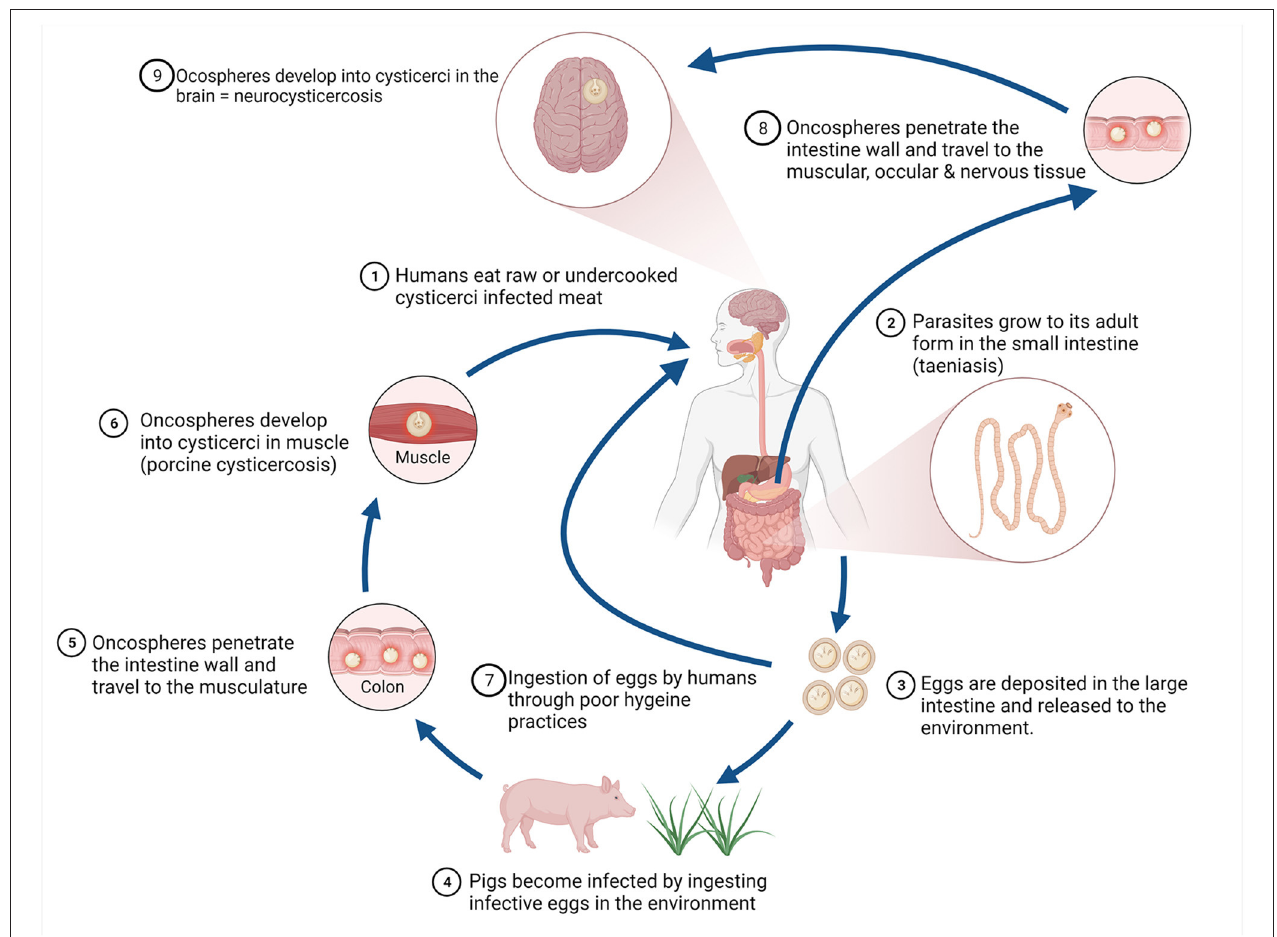
FIGURE 1 | Life cycle of Taenia solium . Figure created with